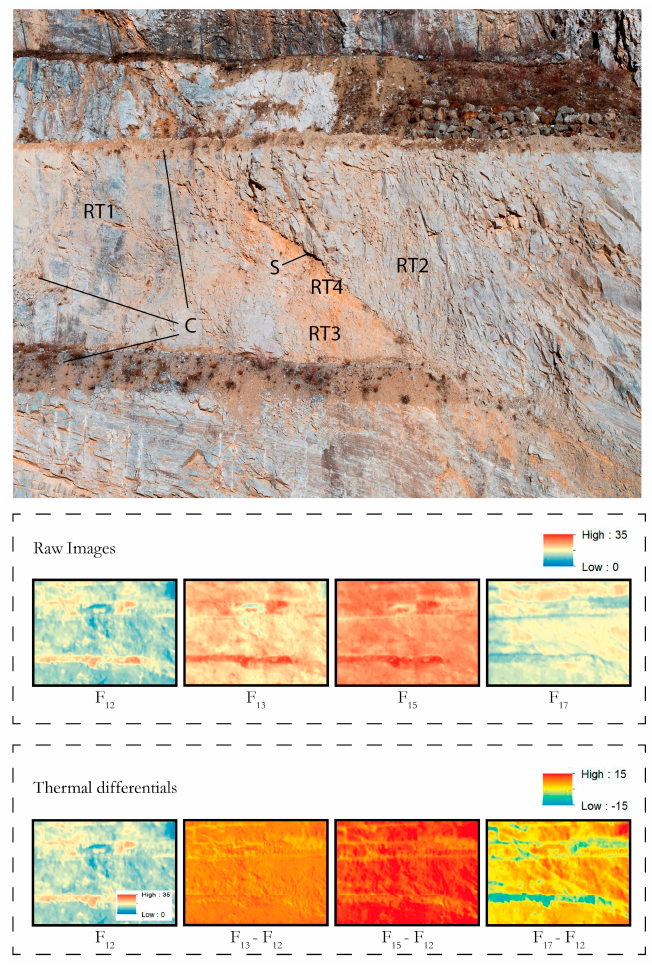
Figure 8. Winter measurement session, raw images, and thermal differentials.